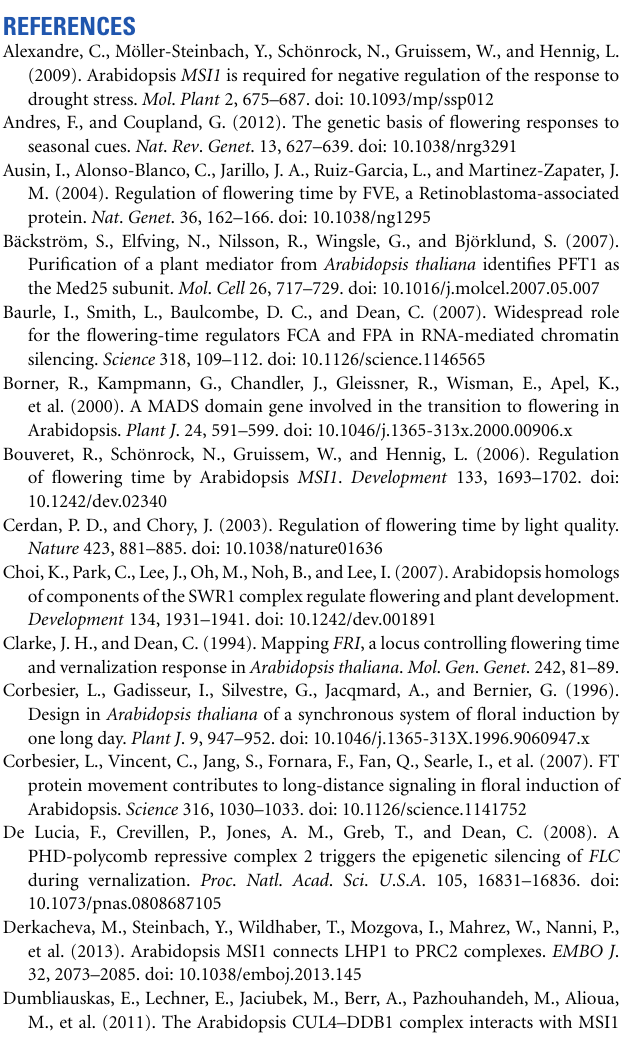
Supplementary Table 1 | Primers used for genotyping and cloning. Supplementary Table 2 | qRT-PCR primers used in this study. Shown are the forward and reverse primers with the appropriate Universal probe library (UPL) (Roche) probe